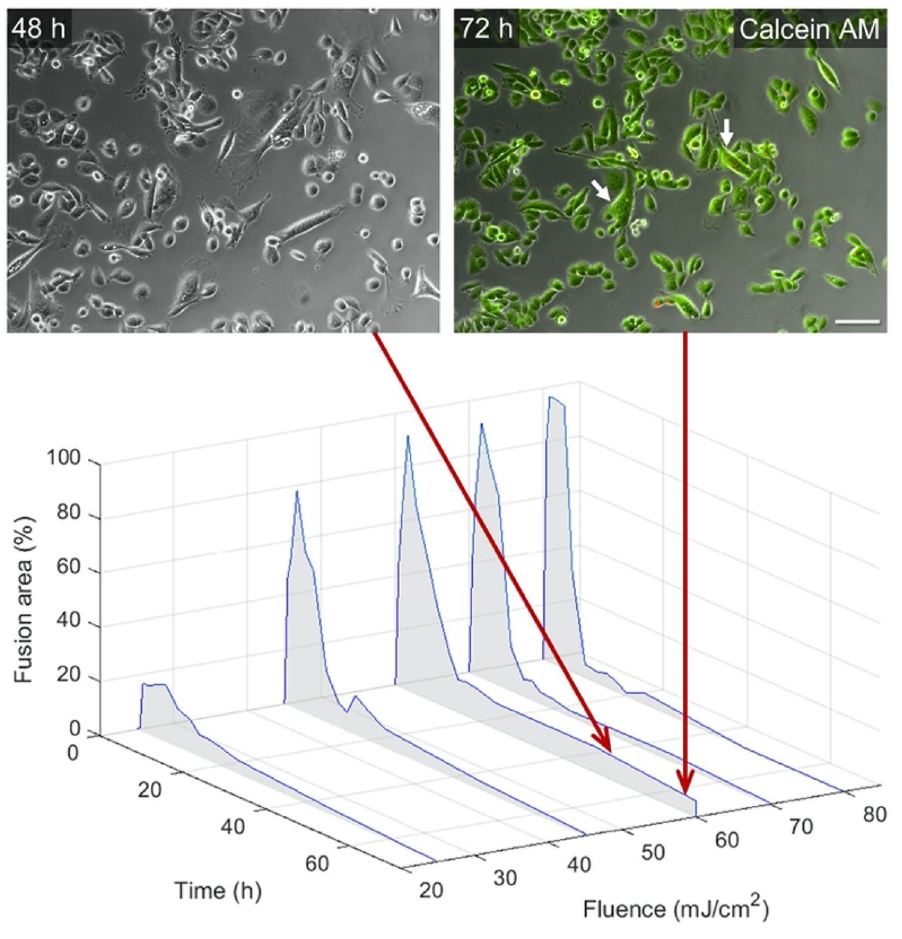
Figure 4. Survival of the fused cells 72 h after irradiation. A few multinucleated fused cells comprised of 2–5 nuclei had remained viable after 60 mJ/cm 2 pulse fluence, as evident by the Calcein AM green fluorescence and the lack of Propidium Iodide (red) staining. Scale bar represents 50